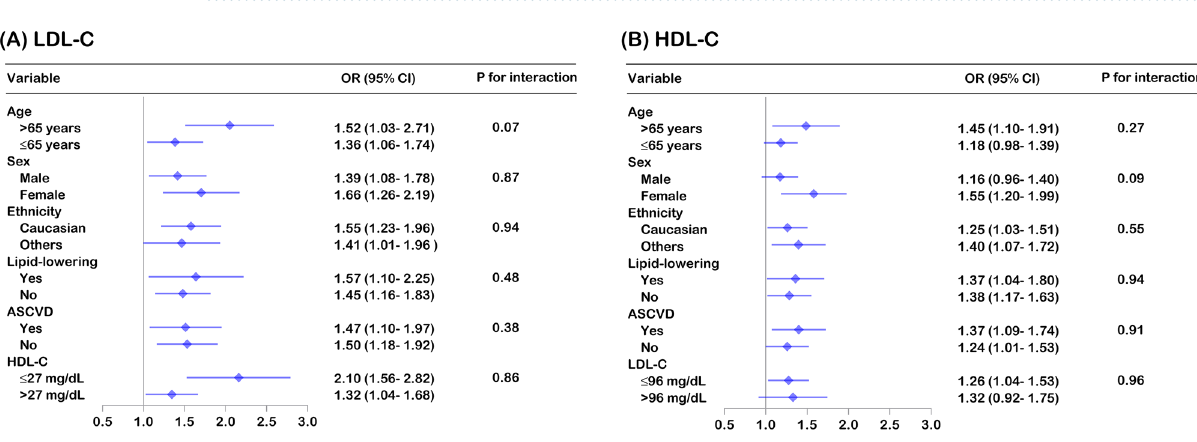
Figure 3. Multivariable adjusted all-cause mortality risk for LDL-C and HDL-C levels stratified by covariates. Forest plot of the odds ratio for all-cause mortality stratified by age, sex, ethnicity, lipid-lowering therapy, ASCVD, LDL-C and HDL-C levels, with the first quintile (≤ 50 mg/dL) compared to the fifth quintile of LDL-C levels (≥ 115 mg/dL) and the first quintile (≤ 28 mg/dL) compared to the fourth quintile of HDL-C levels (43–52 mg/dL). The model was adjusted by age, sex, ethnicity, BMI, heart rate, mean blood pressure, disease severity score (APACHE score, Glasgow Coma Score), lab measurement (LDL-C, HDL-C, TC, TG, white blood cell, hemoglobin, platelet and albumin), primary disease of admission (circulatory disease, respiratory disease, digestive disease, neurological disease, genitourinary disease and endocrine disease), pre-admission comorbidities (ASCVD, diabetes, hypertension, heart failure, COPD and renal dysfunction), medication (lipid- lowering therapy, antiplatelet drug and anticoagulant), mechanical ventilation and